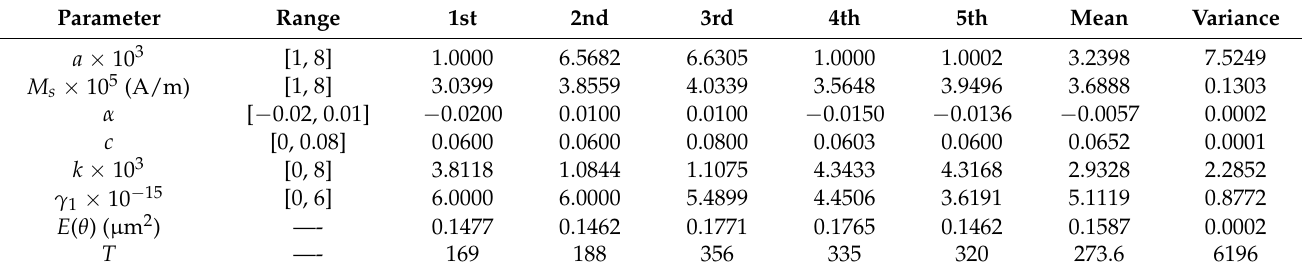
Table 2. Repeated identification results of the PSO.